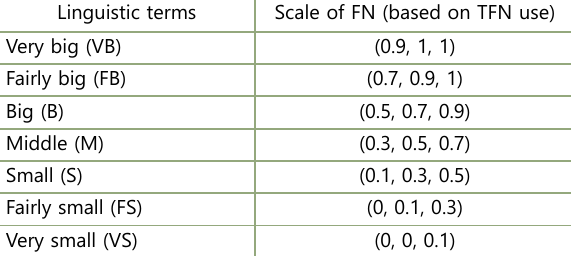
Table 3. Linguistic term for weights of criteria (Zheng 2015) Linguistic